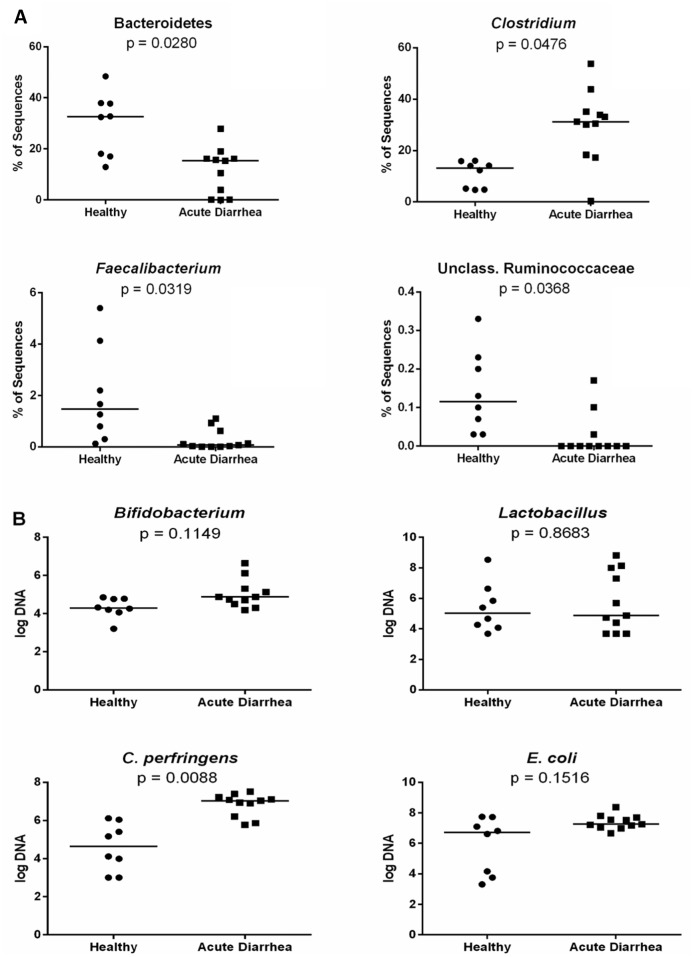
Groups of interest based on A) Sequencing (% of sequences) and B) quantitative PCR results. The qPCR data was expressed as log amount of DNA for each particular bacterial group per 10 ng of isolated total DNA.Acute Diarrhea = both groups combined (NHD and AHD). Bars represent the median value for each group. P-values adjusted based on the Benjamini and Hochberg false discovery rate.